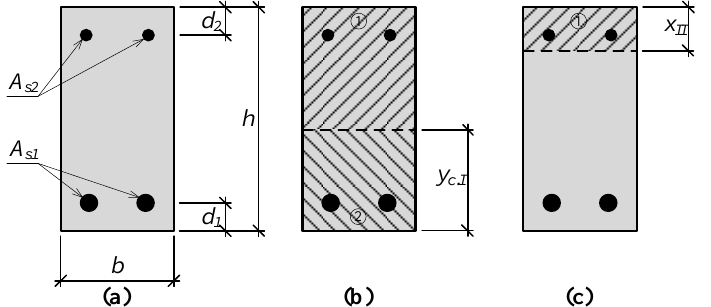
Figure 3. A change in the depth of the neutral axis of the RC beam: ( a ) Cross-section of the beam ( b ) depth of the neutral axis before vertical cracks will open; ( c ) depth of the neutral axis when vertical cracks are opened.